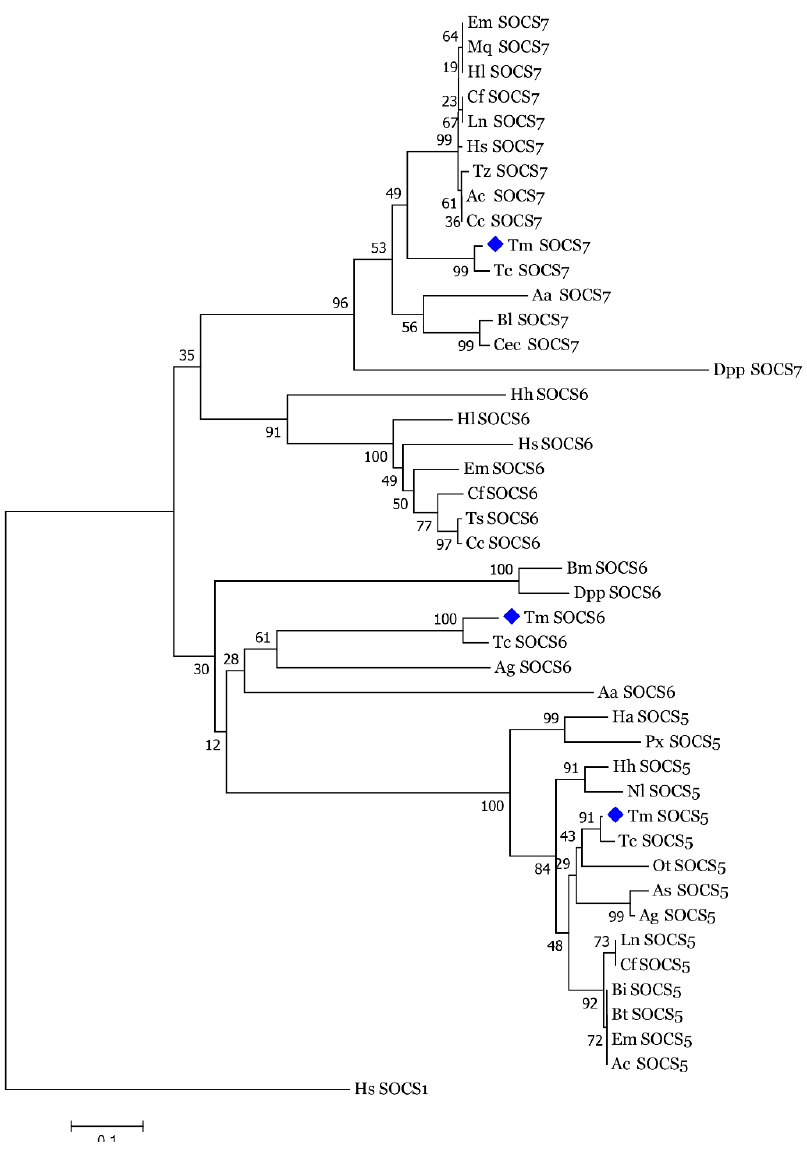
Figure 7. Phylogenetic analysis of TmSOCS5, TmSOCS6, and TmSOCS7 and insect SOCS5, SOCS6, and SOCS7 proteins. The tree was constructed in MEGA7 using the neighbor-joining method. Numbers at the nodes are the bootstrap support of 1000 replicates. Homo sapiens SOCS1 (Type II member) was used as an outgroup. indicates T. molitor SOCS5, SOCS6, and SOCS7 proteins.